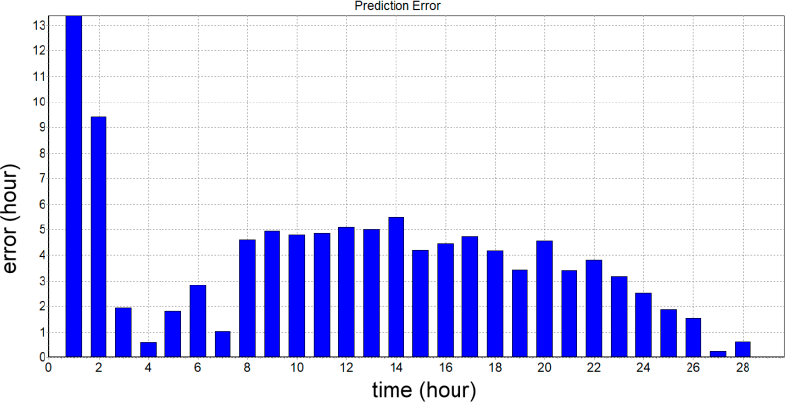
Figure 12. The errors of the estimated harvest time.